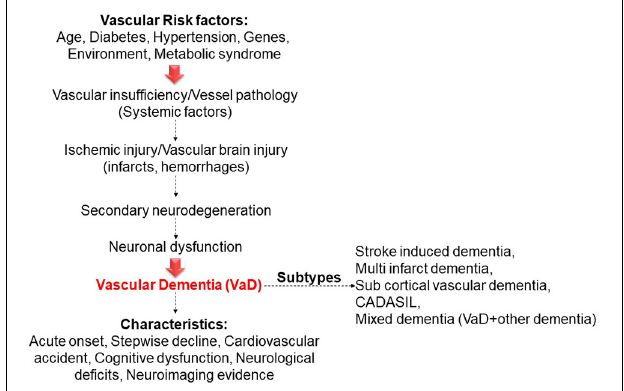
FIGURE 1 | Subtypes of VaD that are associated with some of the vascular risk factors and their characterized features.